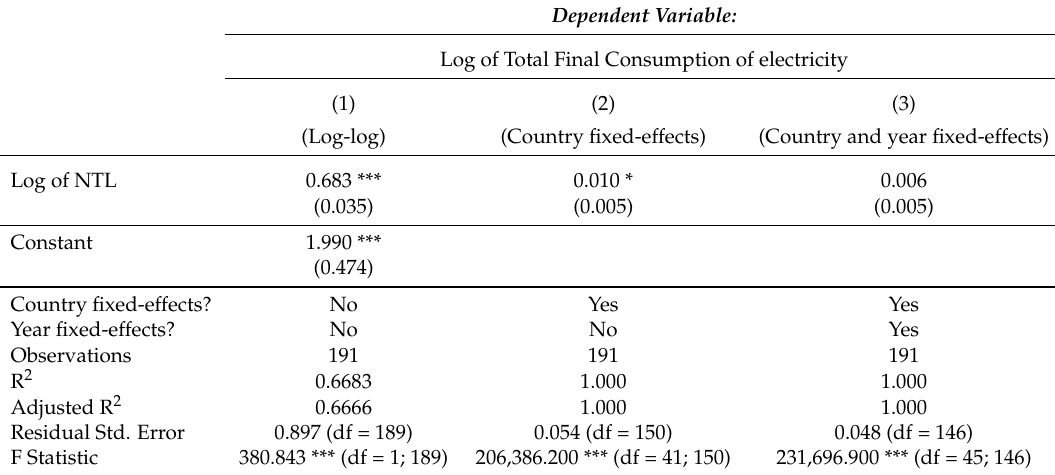
Table A4. Regression for COMMPUB—High-income